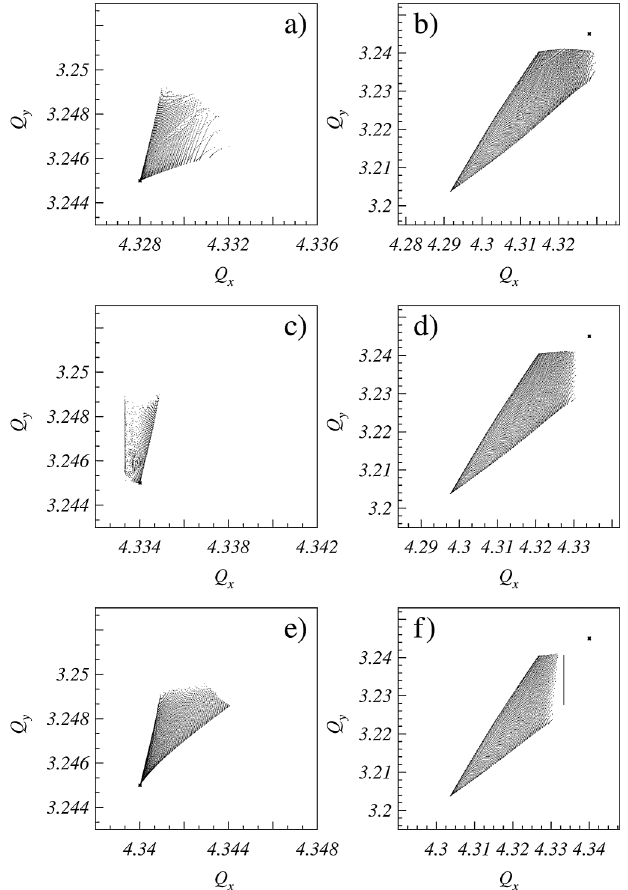
FIG. 11. Tune footprints: In pictures (a), (b) the tune is Q x ¼ 4 : 328 , in (c), (d) the tune is Q x ¼ 4 : 334 , in (e), (f) the tune is : 34 . The pictures on the left provide the tune footprint Q x ¼ 4 from the pure nonlinear lattice. The pictures on the right include also the effect of the space charge. Note that space charge has a dominant effect over the detuning of the lattice